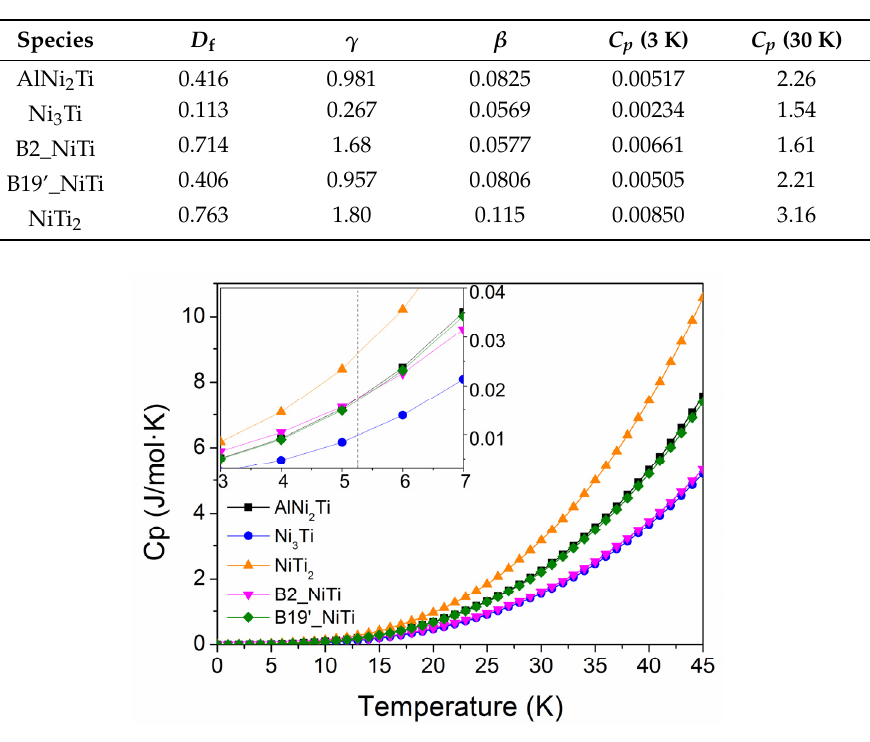
Figure 9. The heat capacity of AlNi 2 Ti and Ni-Ti binary compounds plotted in the range of 0–45 K.